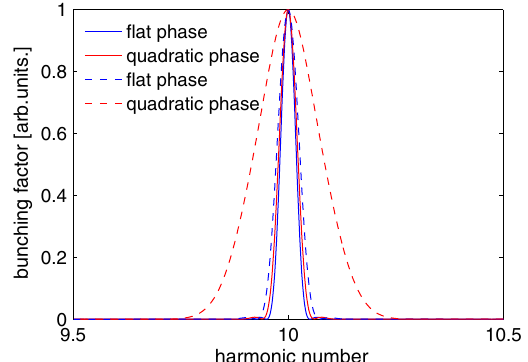
FIG. 8. Bunching factor spectra for different cases: seed laser with flat phase and considering the slippage effect (blue solid line); seed laser with quadratic phase and consid- ering the slippage effect (red solid line); seed laser with flat phase and ignoring the slippage effect (blue dashed line); seed laser with quadratic phase and ignoring the slippage effect (red dashed line).